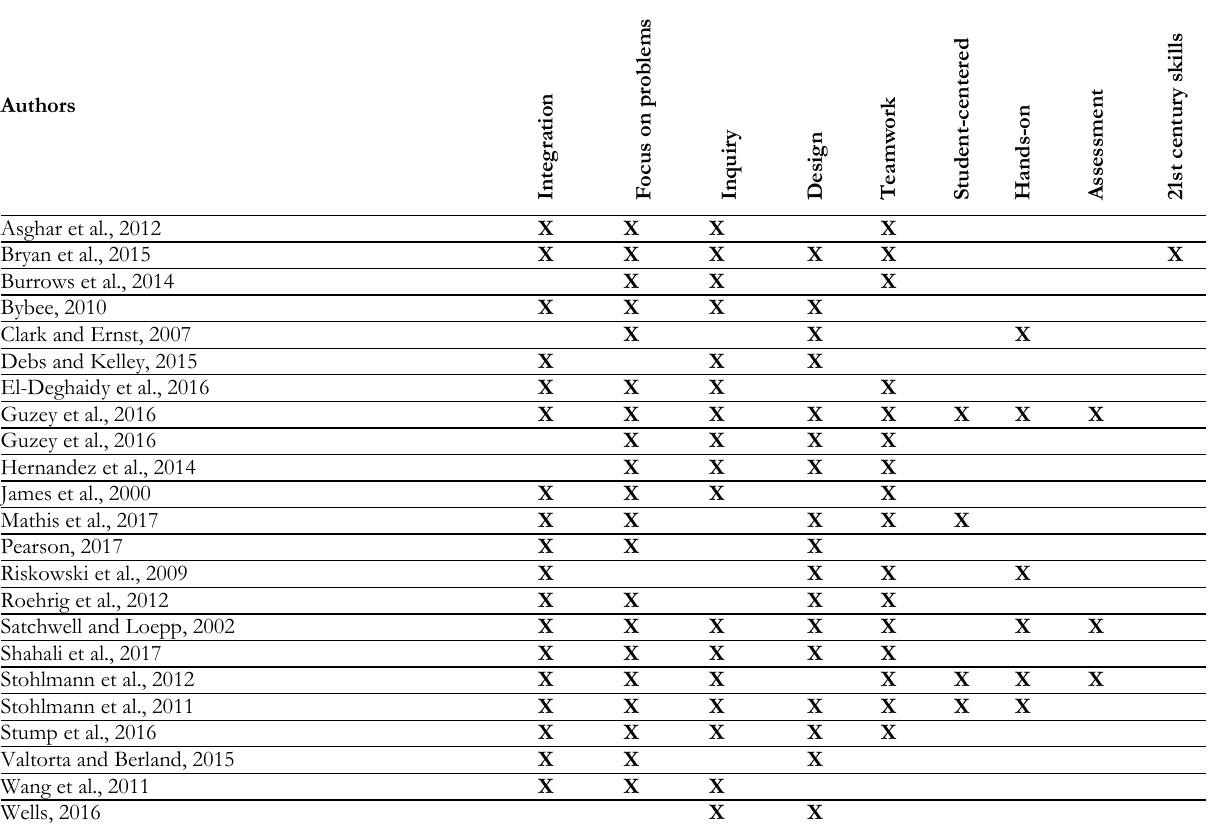
Table 2. Overview of the instructional categories present in each